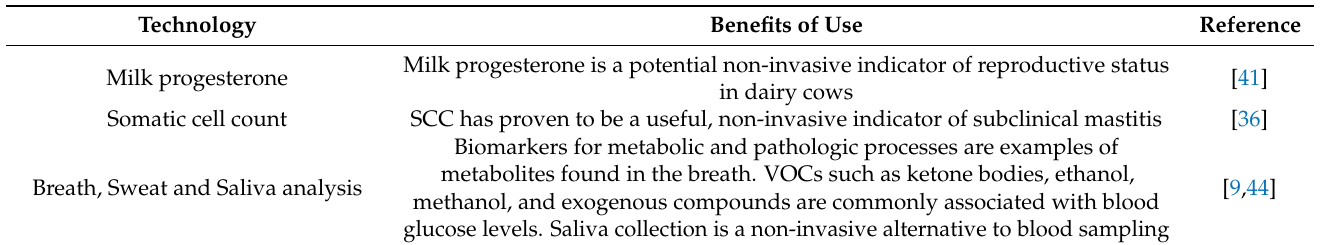
Table 1. Body fluid analysis and its